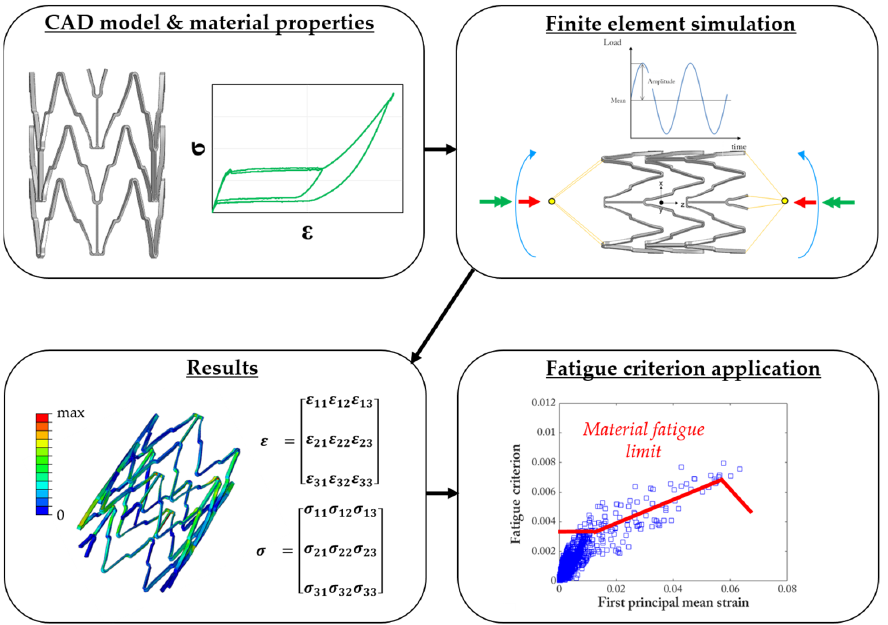
Figure 6. In silico workflow for the fatigue analysis of a Ni-Ti device. Starting from the knowledge of the design and material properties, proper cyclic boundary conditions are applied to the device to assess the local stress and strain quantities at each location of the model. Then, each element is evaluated through a proper fatigue index (represented through a blue box in the plot) to discriminate between safe and critical conditions with respect to the material’s fatigue limit (red line in the plot).